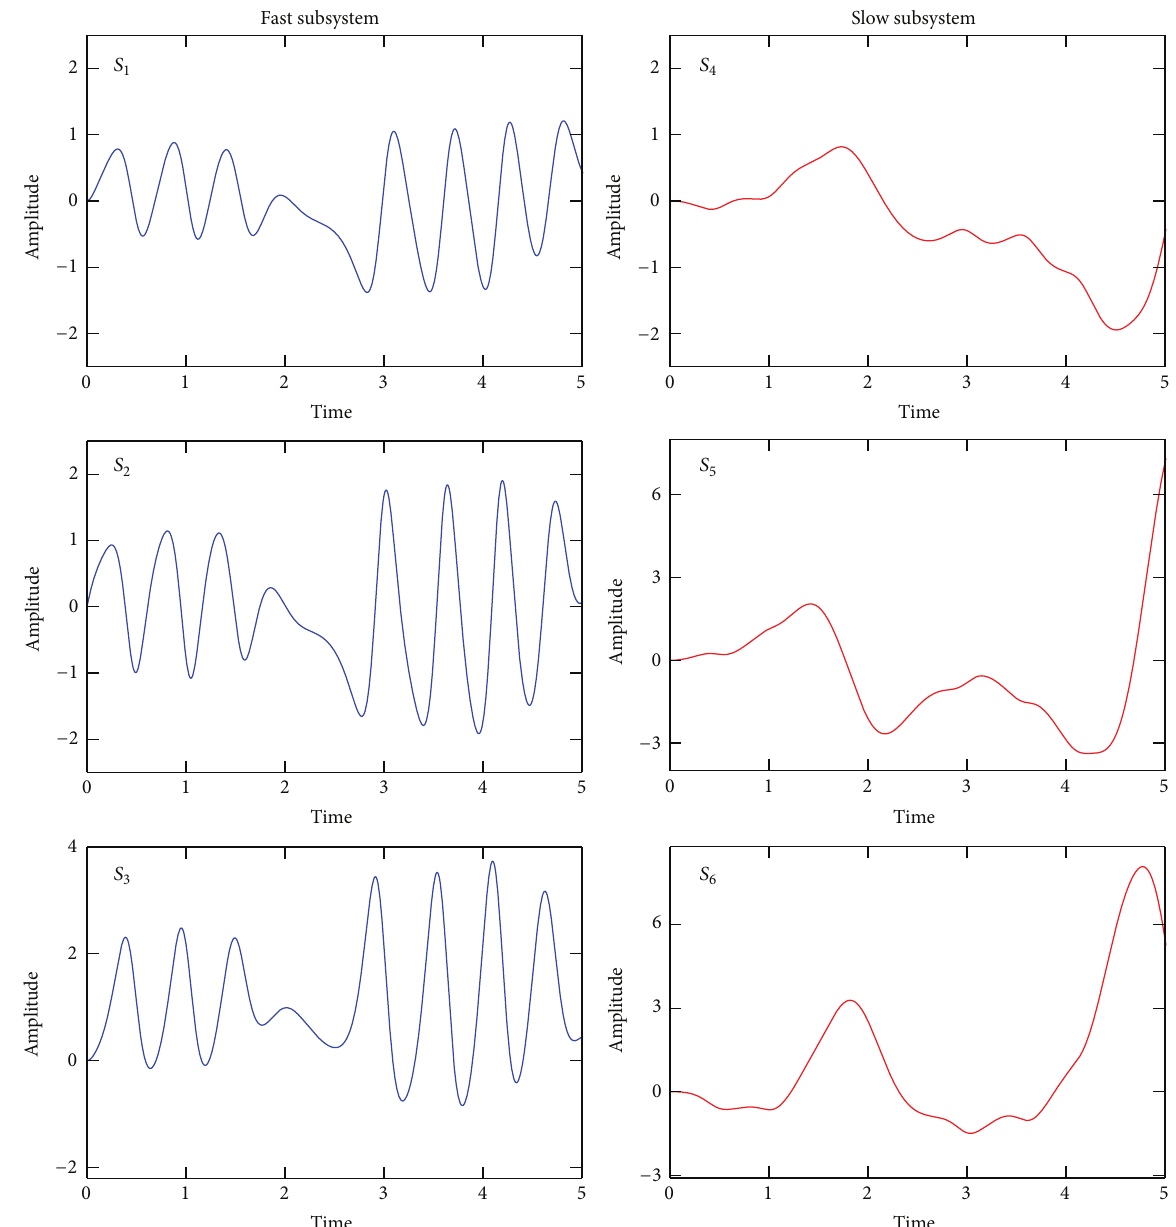
Figure 8: Time dynamics of sensitivity functions with respect to parameter 𝑟 on the time interval [0,5] for 𝑐 0 = 0.9 .